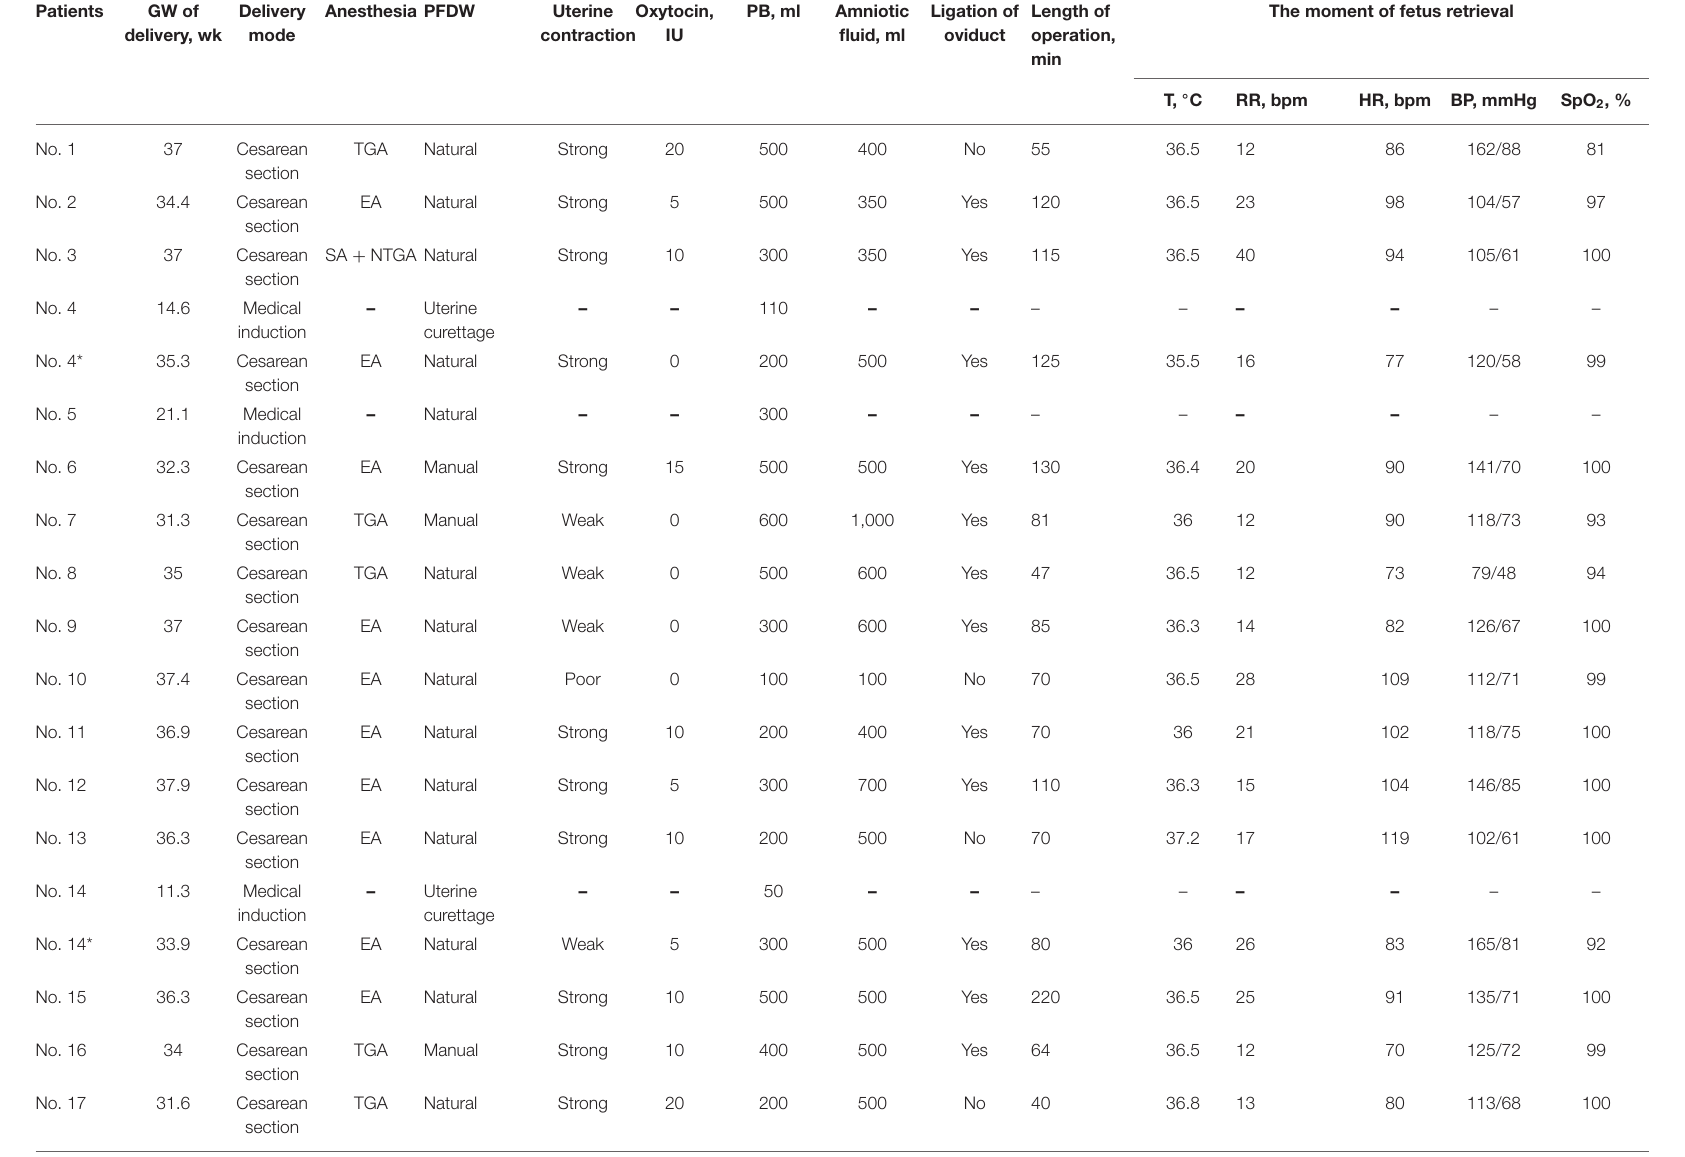
TABLE 3 | Intraoperative management of pregnancy termination in PAH patients with pregnancy.